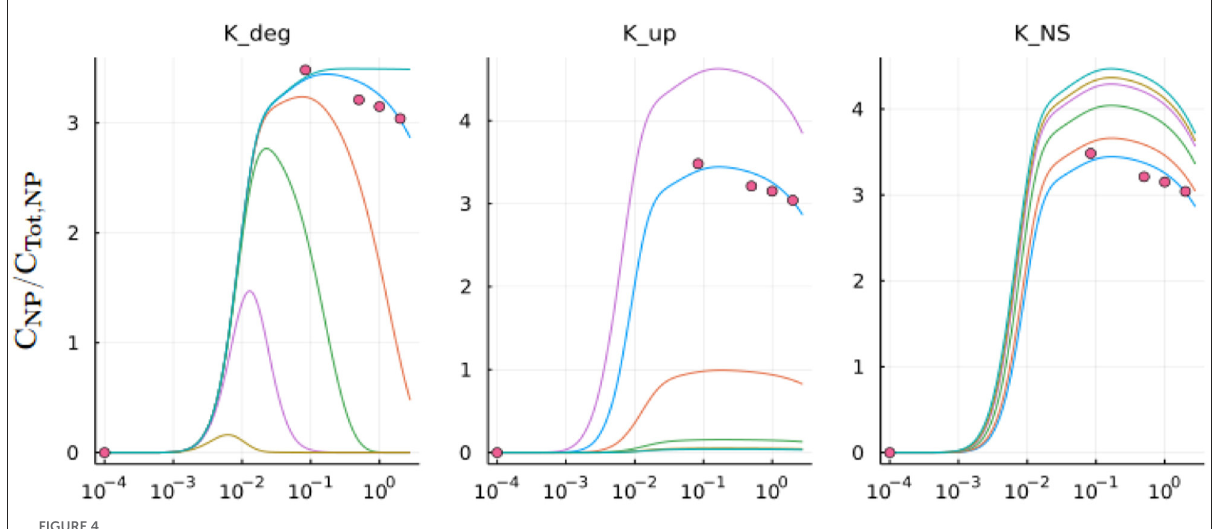
FIGURE4 Local sensitivity analysis: Plot for the K deg , K up , and K NS parameters in the spleen compartment of the model. The blue line is the model output using optimized parameters obtained via the sensitivity analysis. Other lines show the model output with unoptimized K deg , K up , and K NS